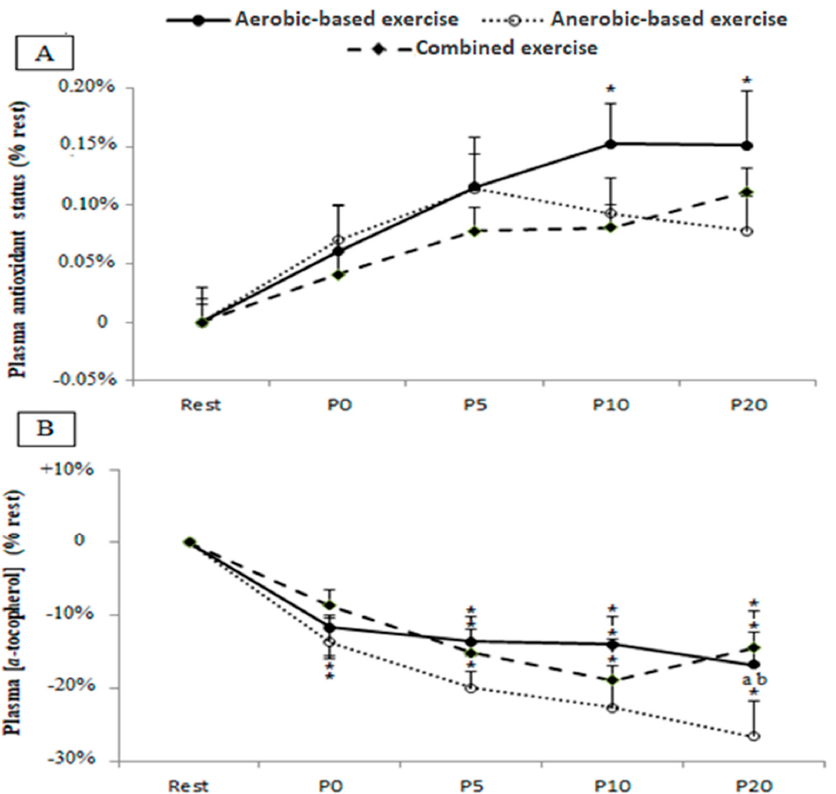
Figure 3. Plasma antioxidant status (panel A) and α -tocopherol concentration (panel B) before (Rest), immediately after (P0), and 5 (P5), 10 (P10), and 20 (P20) min after aerobic, anaerobic, and combined (anaerobic and aerobic) exercise. Data are expressed as the % change from pre-exercise resting concentrations. *: significant di ff erence when compared to pre-test values; a: significant di ff erence when compared to the aerobic exercise; b: significant di ff erence when compared to the combined (anaerobic and aerobic)